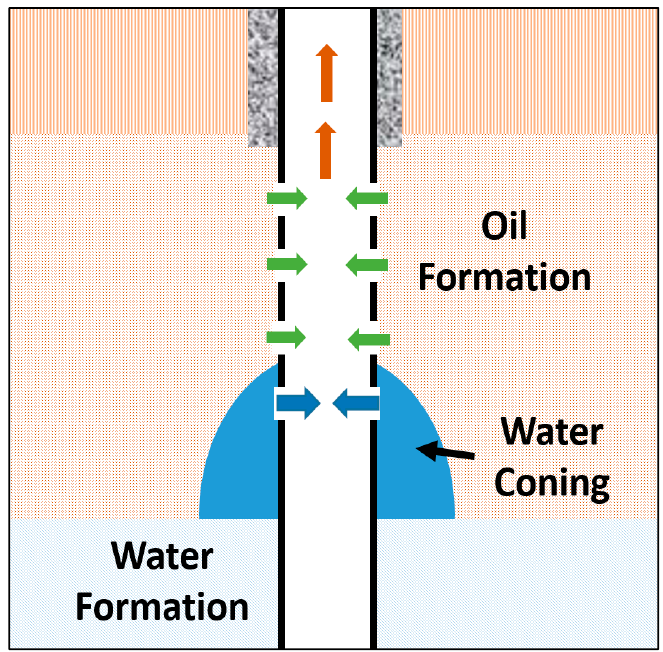
Figure 3. Water coning.